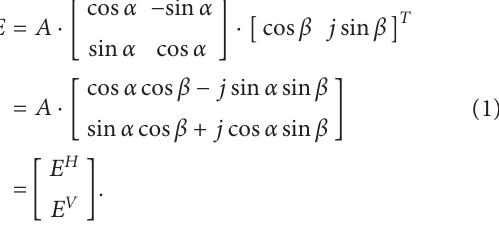
Figure 1: Polarization